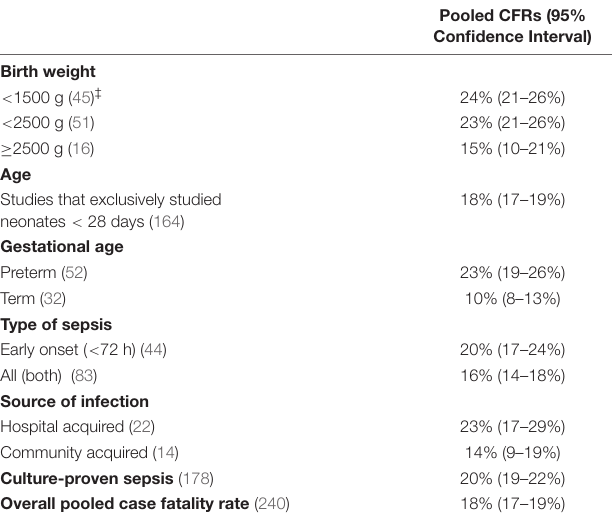
TABLE 4 | Pooled Case Fatality Rates for study population characteristics.